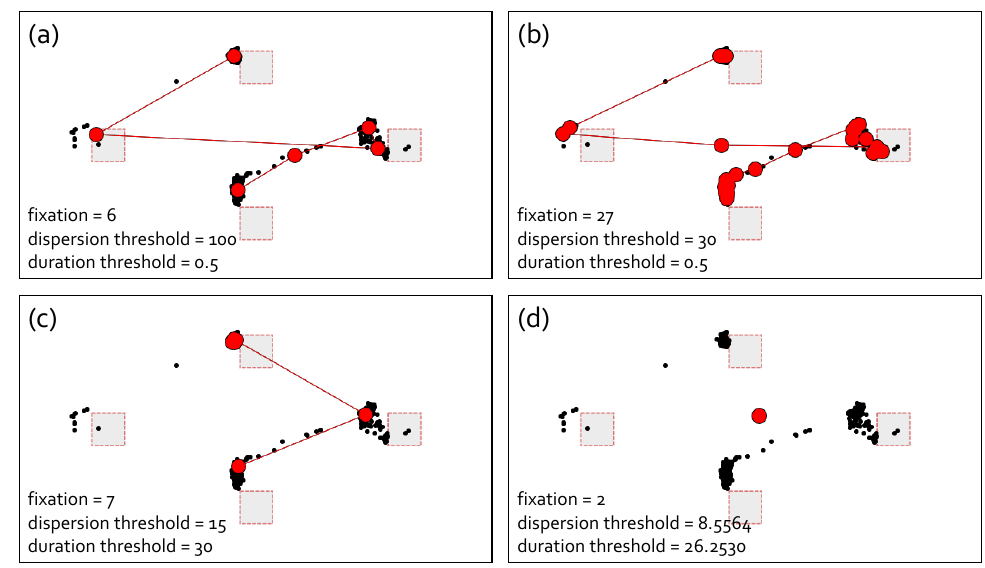
Figure 4. I-DT fixation identification. ( a – d ) The different cases of fixation identifications with the I-DT algorithm. The parameter settings are displayed in each image. Similar to Figure 3, the black dots denote the raw gaze points, and the red dots indicate the fixations. The red links are the saccades. DBSCAN with IQR analysis